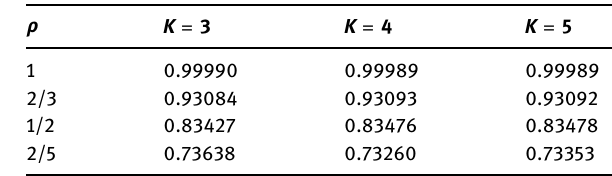
Table 5: The error for di ff erent values of ρ and for di ff erent number of non zero terms ( K ) in the series solution of Example 4.2 by the DTM ( at t 0.5 =